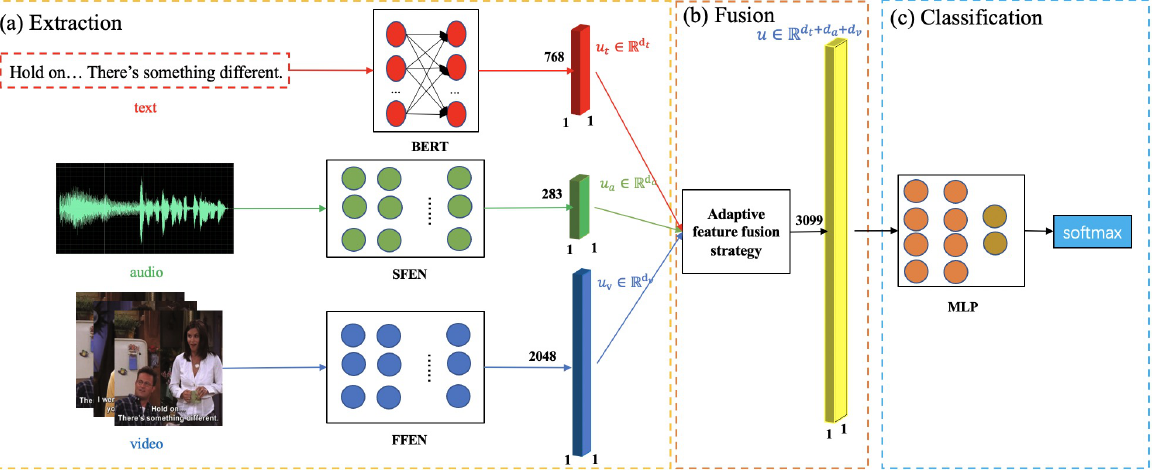
Figure 2. The whole architecture of the network we proposed. It includes three key steps: ( a ) mul- timodal feature extraction, ( b ) adaptive feature fusion, and ( c ) feature classification. Among them, BERT represents a self-encoding language model presented by Devlin et al. [12], SFEN represents the speech feature extraction method presented by Castro et al. [9], and FFEN represents the facial feature extraction network we use, which we will describe in detail in Section 3.2. The adaptive feature fusion strategy is introduced, in fact, in Section 3.3. MLP stands for Multilayer Perceptron and is described in detail in Section